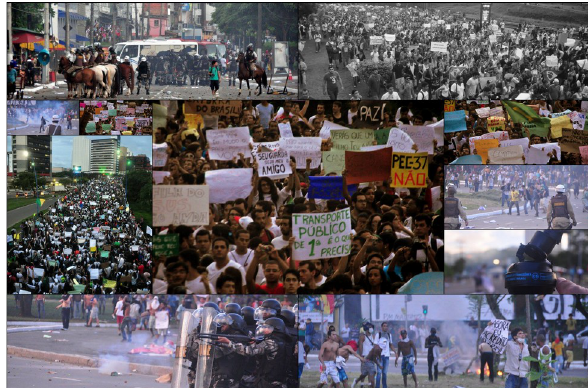
Figure 2. Claiming for urban services and social rights in Brazil